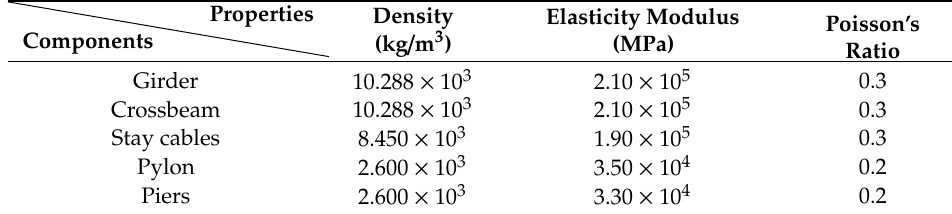
Table 4. Material properties for different components.